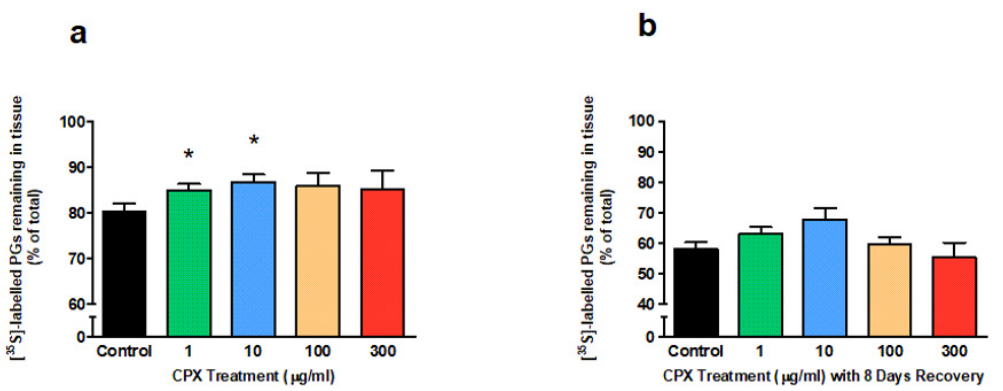
Figure 1. 35 S-sulphate labelled proteoglycans (PGs) remaining in equine derived tendon explant cultures after ( a ) 4 days treatment with 1, 10, 100 or 300 µg/mL CPX (n = 4) and ( b ) subsequent 8 days without CPX treatment (recovery period; n = 4). Values represent mean ± SEM and are expressed as % of total newly synthesised pool remaining in tissue. * p < 0.05 vs.